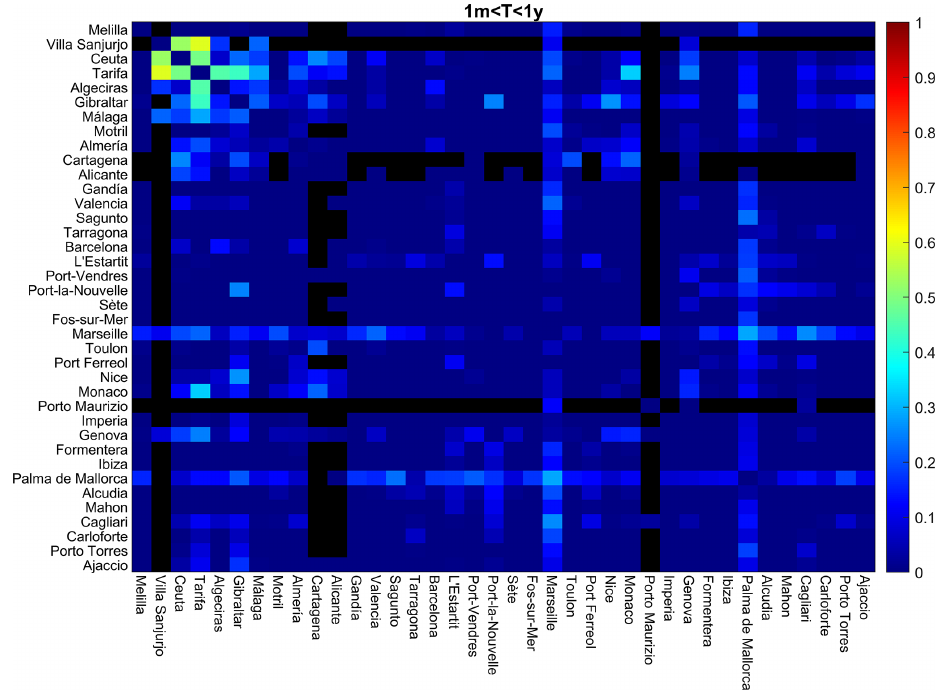
Figure A2. Differences between the correlation of tide gauge series and the correlation between SOCIB model series (with random noise added) at the points closest to each tide gauge for the frequency band 1 m<T < 1 y